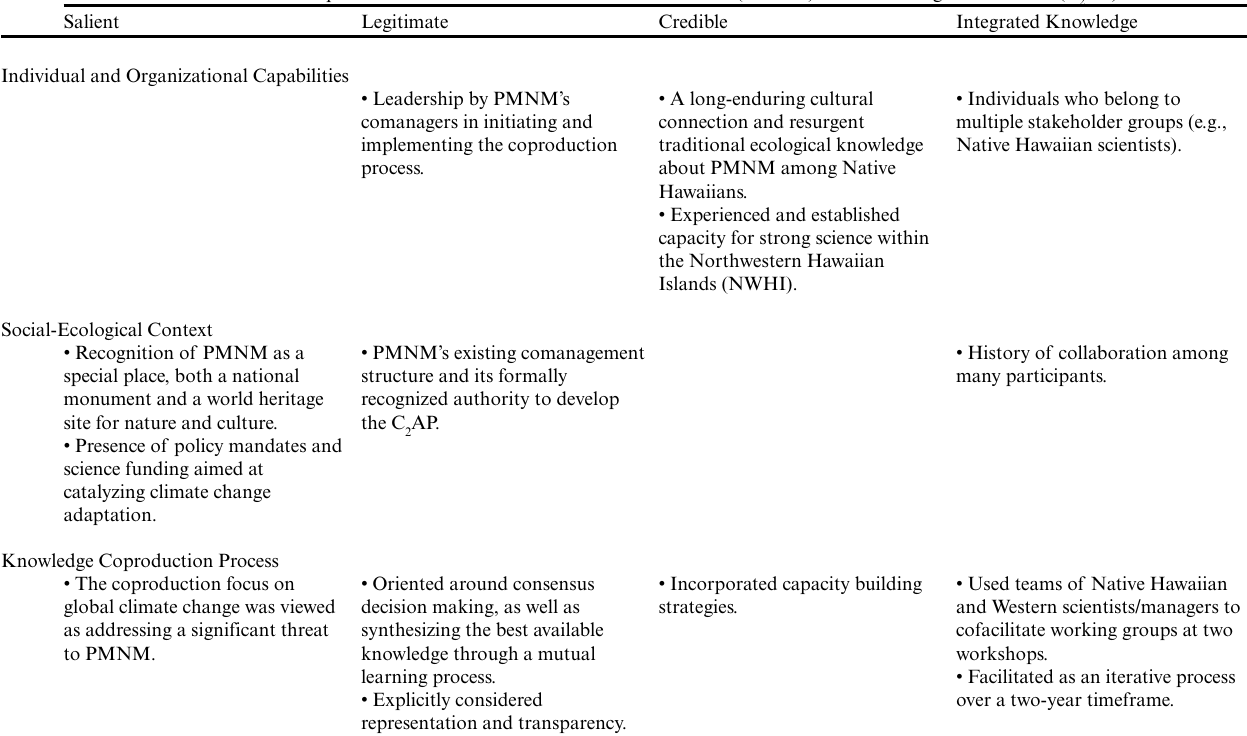
Table 2. Ways the three coproductive capacities (rows) contributed to establishing the C ways they supported the integration of Native Hawaiian and Western scientific